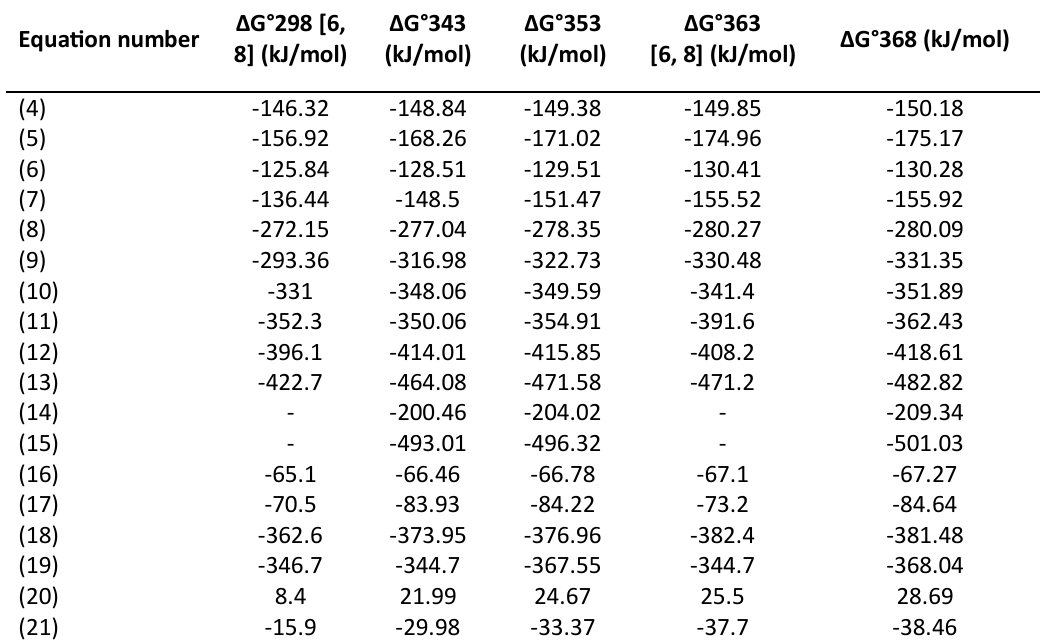
Table 1. The values of standard Gibbs energy of